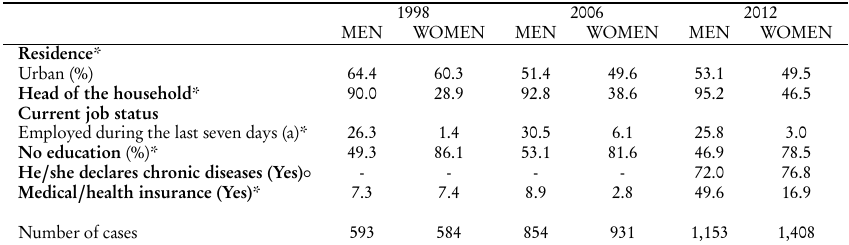
Socio-demographic characteristics of older Egyptians (65 years and over) by selected variables. Notes: * Percentage on the total of elderly people in the age class; (a): employed (participation in any employment) in the last seven days. Weighted data. Source: Angeli,